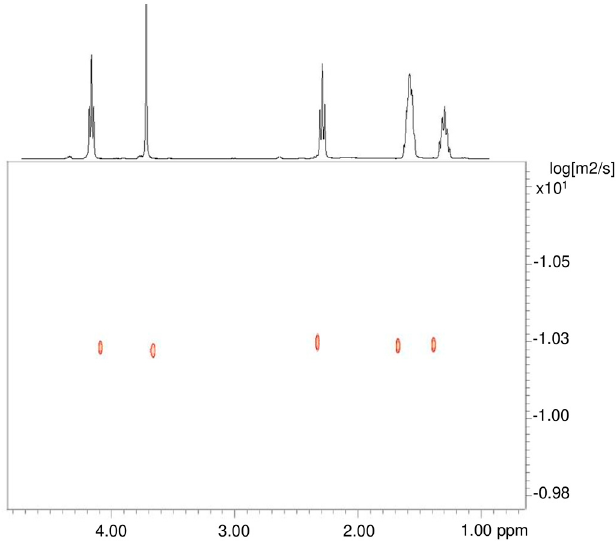
Figure 2. DOSY NMR spectrum (400 MHz, CDCl 3 , 298 K) of triblock PCL-PEG-PCL